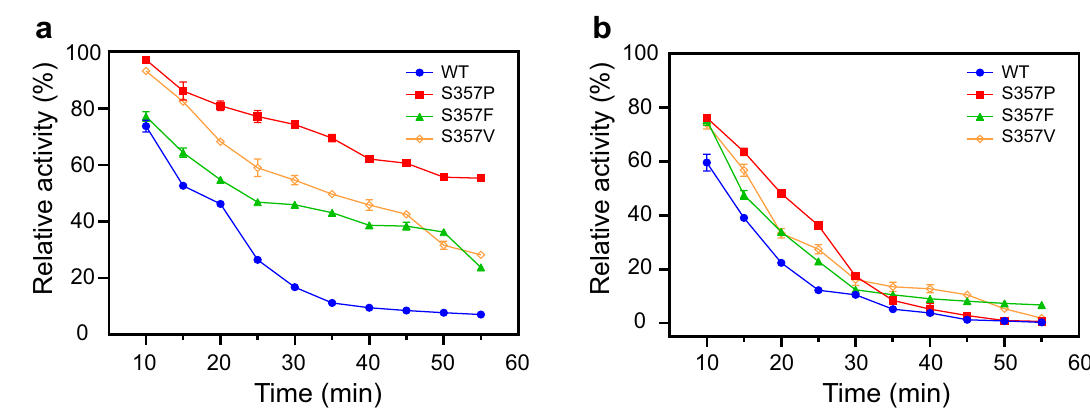
Fig. 5 Thermostability of the wild-type and mutant dextranase AoDex during the incubation at 60 °C a and 65 °C b . Relative activity is defined as the percentage of maximum enzymatic activity under the corresponding experimental conditions. The activities were determined at pH